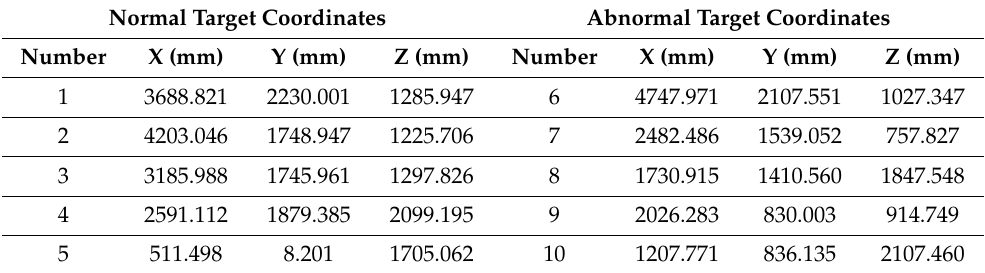
Table 5. Ten sets of target